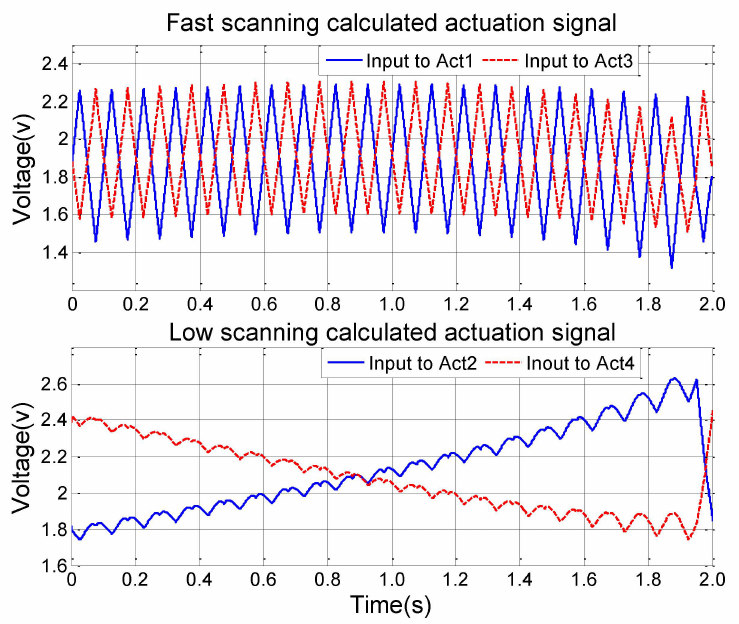
Figure 10. The calculated control signal including fast scan in X-axis and slow scan in Y-axis.